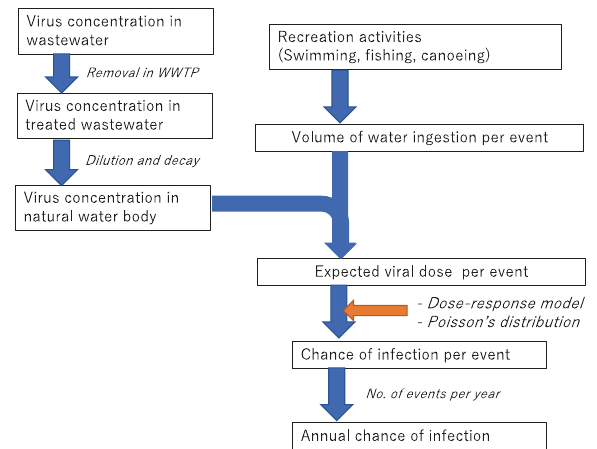
Fig. 1 Framework of QMRA of SARS-CoV-2 in natural water bodies receiving treated